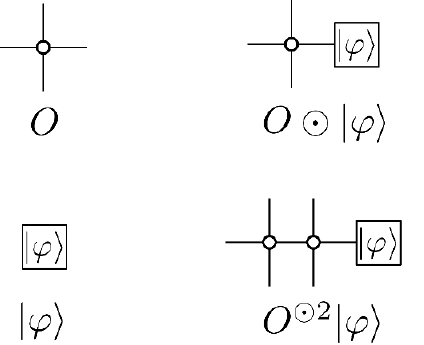
Figure 12 . This (cid:12)gure shows the tensor network representations of E O and E